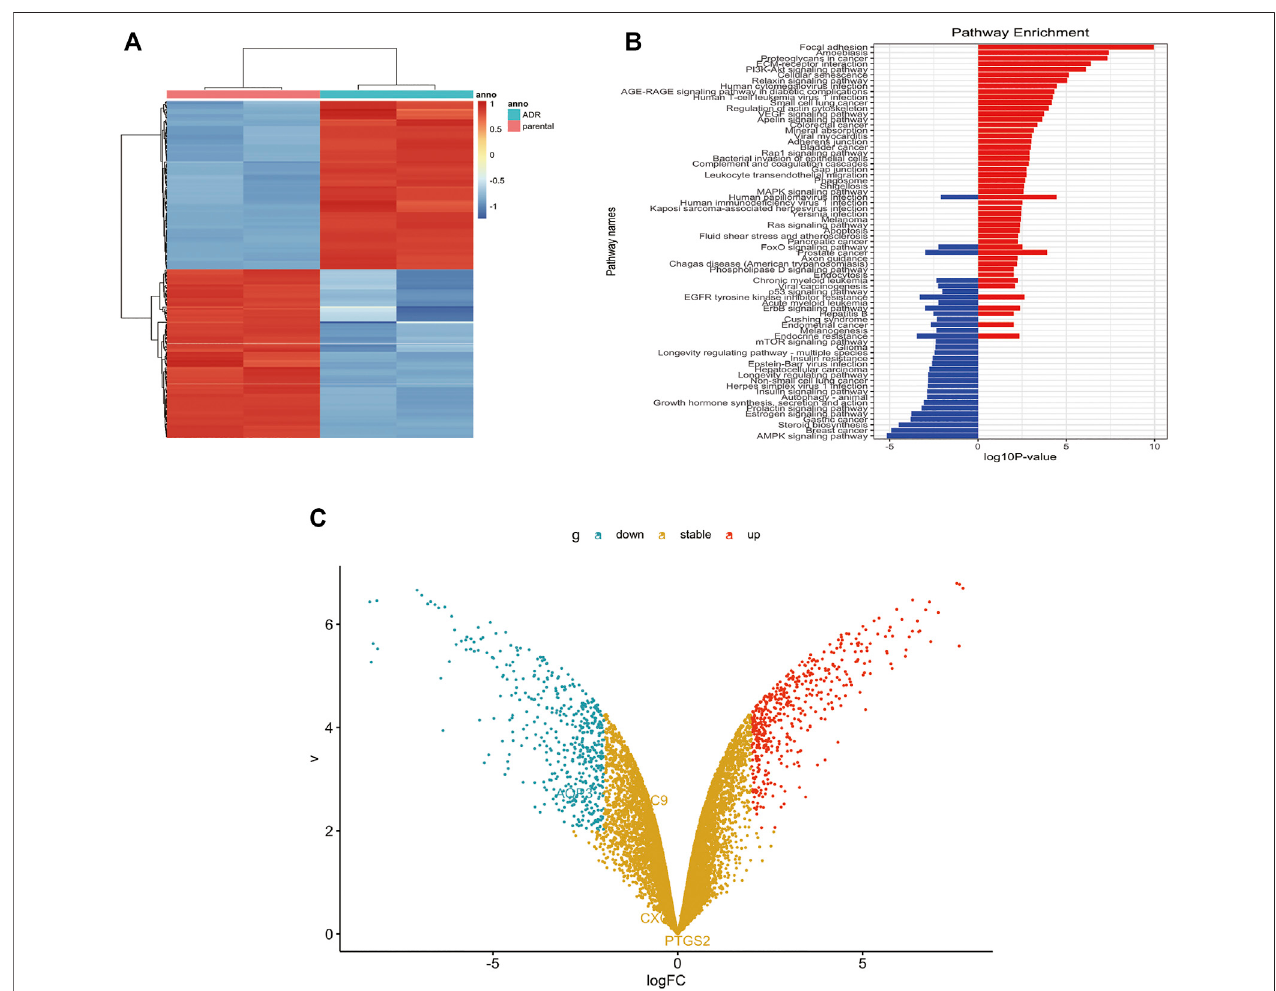
FIGURE 5 | P-gp upregulated in MCF-7/DOX cells. (A) Heatmap of differentially expressed genes in GEO dataset. (B) Analysis of pathways related to drug resistance revealed the PI3K/Akt signaling pathway is the fi fth largest factor. (C) Volcano plot analyzed the differentially expressed gene between MCF-7 cells and MCF- 7/DOX cells. The fold change threshold was > 2, p value was <